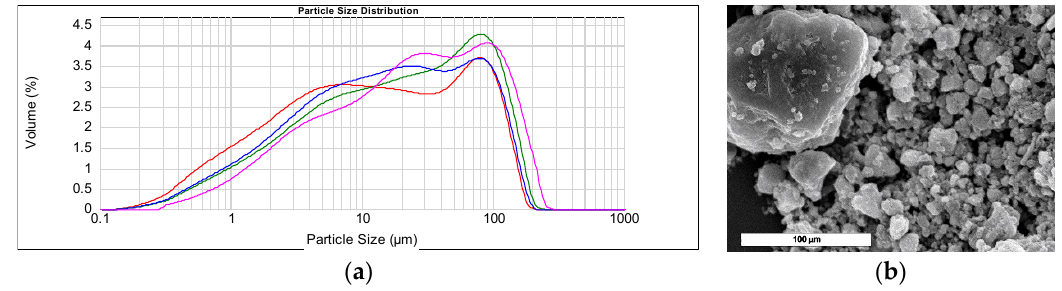
Figure 2. ( a ) Particle size distribution of HSL (red), HSL 600 (green), HSL 750 (blue) HSL 900 (purple) and ( b ) SEM image of HSL sample.